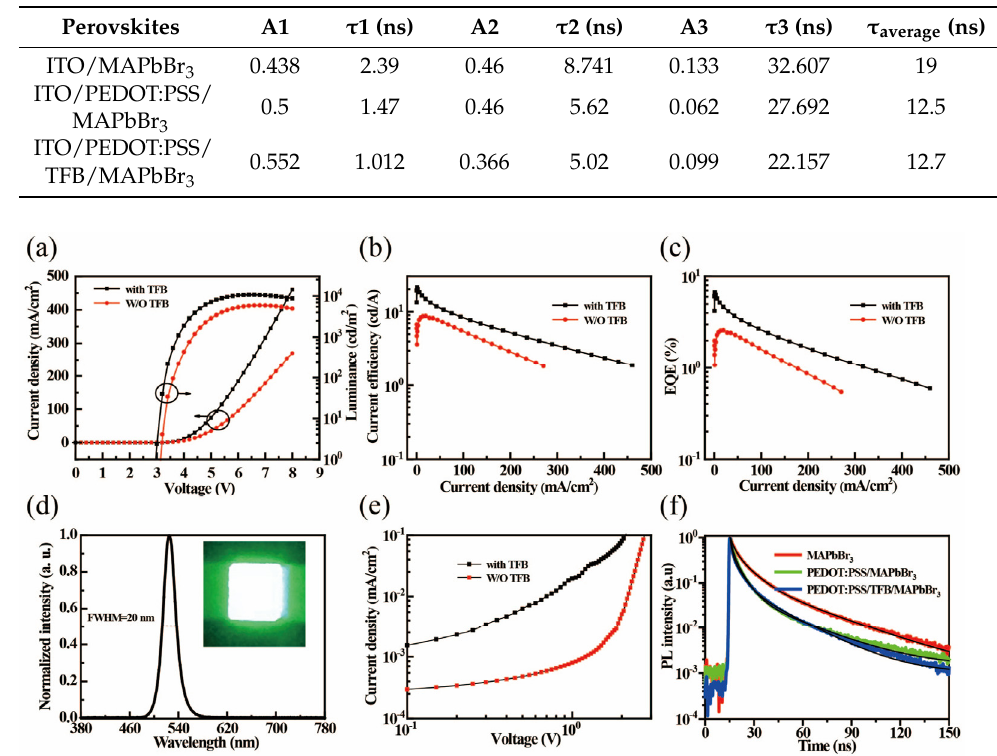
Table 2. The tri-exponential fitting parameters of time-resolved PL decay curves for MAPbBr 3 on different substrate.